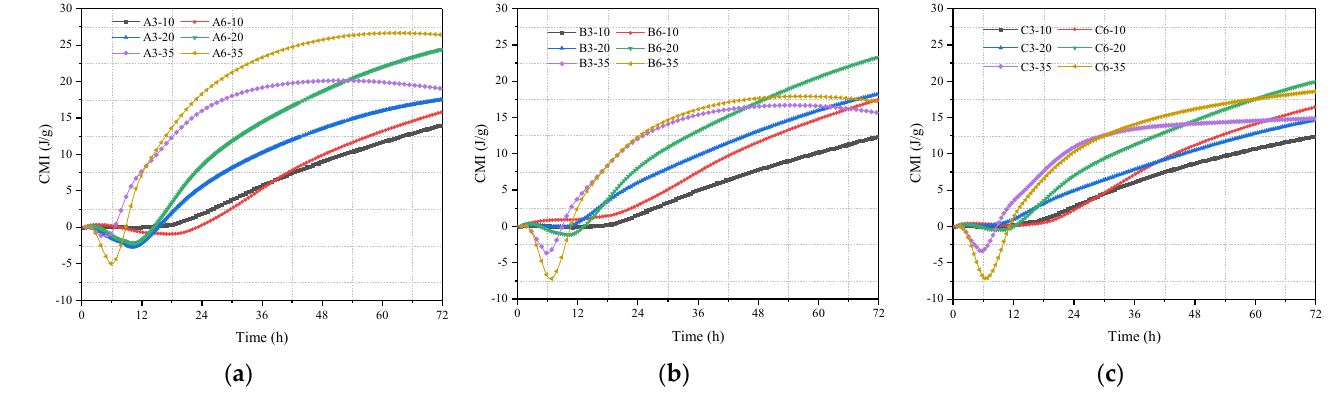
Figure 8. CMI values of FA at different water-binder ratios. ( a ) CMI values of FA at water-binder ratio of 0.4; ( b ) CMI values of FA at water-binder ratio of 0.5; ( c ) CMI values of FA at water-binder ratio of 0.6.